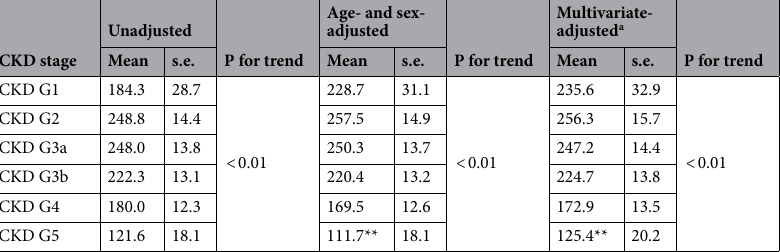
Table 4. Association between CKD stage and the quantity of fruits consumed per day. CKD, chronic kidney disease; s.e., standard error. **P < 0.01 vs mean value of CKD G1. a Adjusted for age, sex, diabetes, history of cardiovascular disease, systolic blood pressure, body mass index, serum albumin concentration, low-density lipoprotein cholesterol, log-C-reactive protein, and urinary protein/creatinine ratio.